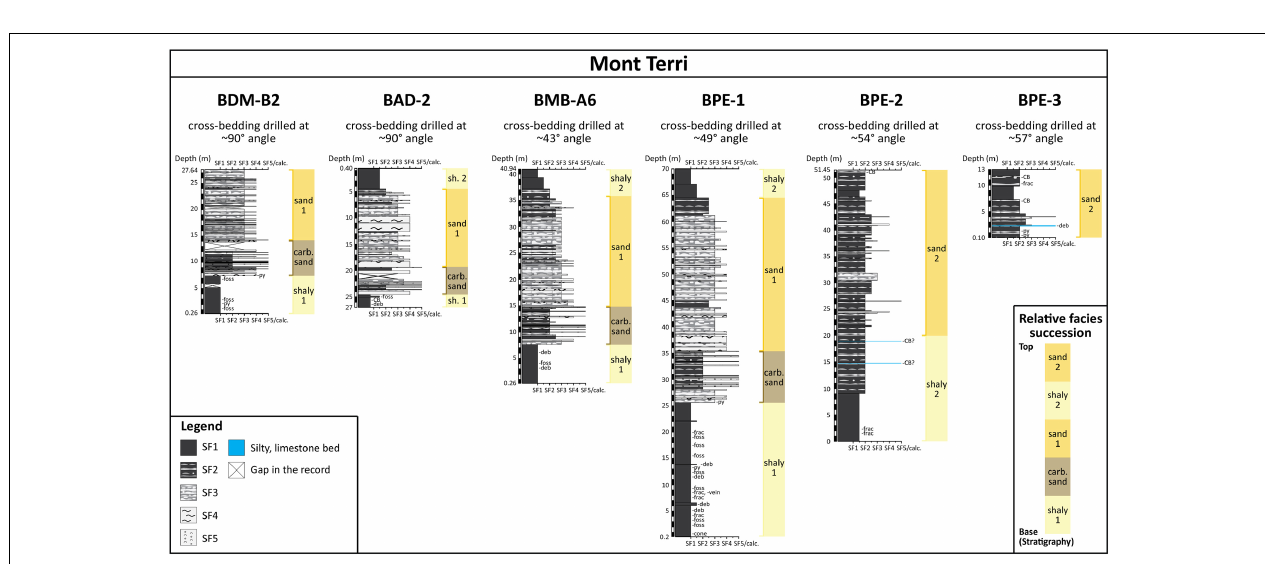
FIGURE 6 | Overview of the Opalinus Clay succession in different drill cores from the Mont Terri rock laboratory. Drilling crossed bedding planes at different angles, resulting in varying subfacies/facies apparent thicknesses. The sketches follow the subfacies classification scheme presented herein. Sub-units at Mont Terri refer to the facies classification as used within the Mont Terri Project (Bossart and Thury, 2008; Hostettler et al., 2017). sh. 1, shaly 1, lower shaly facies; carb. sand, carbonate-rich sandy facies; sand 1, lower sandy facies; sh. 2, shaly 2, upper shaly facies; sand 2, upper sandy facies. calc. (label), calcareous lithology (limestone).